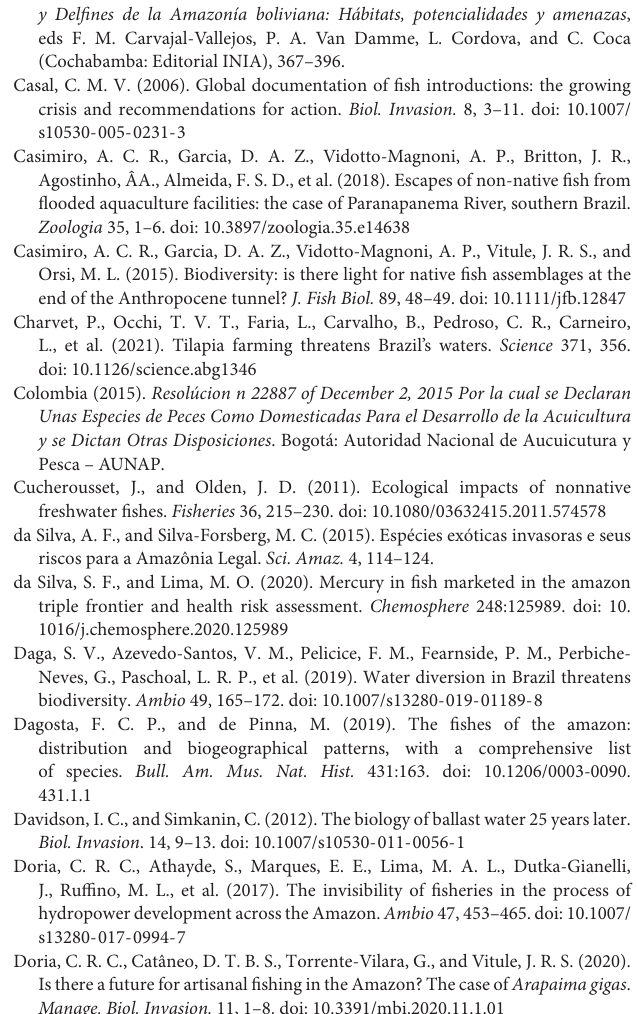
each country (at federal level for Bolivia, Colombia and Ecuador, at state level for Brazil, and province level for Peru). Supplementary Table 2 | Relation between sample effort (data from Jézéquel et al., 2020) and NNF records in Amazon Region (Ancova). Supplementary Table 3 | Actions that promoted or allowed the invasion of non-native fishes in the studied sites. Supplementary Table 4 | Published invasion recorded and related field impact. Supplementary Table 5 | Current legislation on aquaculture, fisheries and environmental licensing by countries and states. Supplementary Material 1 | Amazon Non-native Fish database